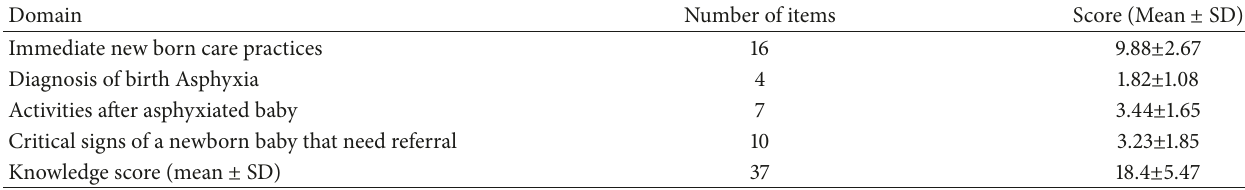
Table 2: Knowledge regarding neonatal resuscitation in health care professionals, Ethiopia.